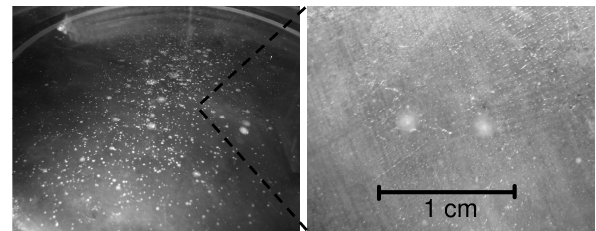
Fig. 3. Images of crystals grown on the sugar solution.